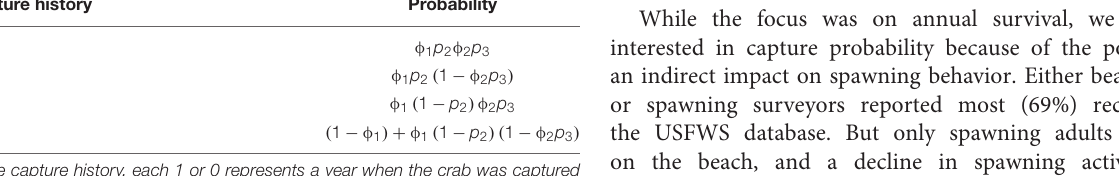
TABLE 2 | Example capture histories and their expected probabilities as a function of apparent survival ( φ i ) and capture probability ( p i ) for a 3-year tagging study. Capture